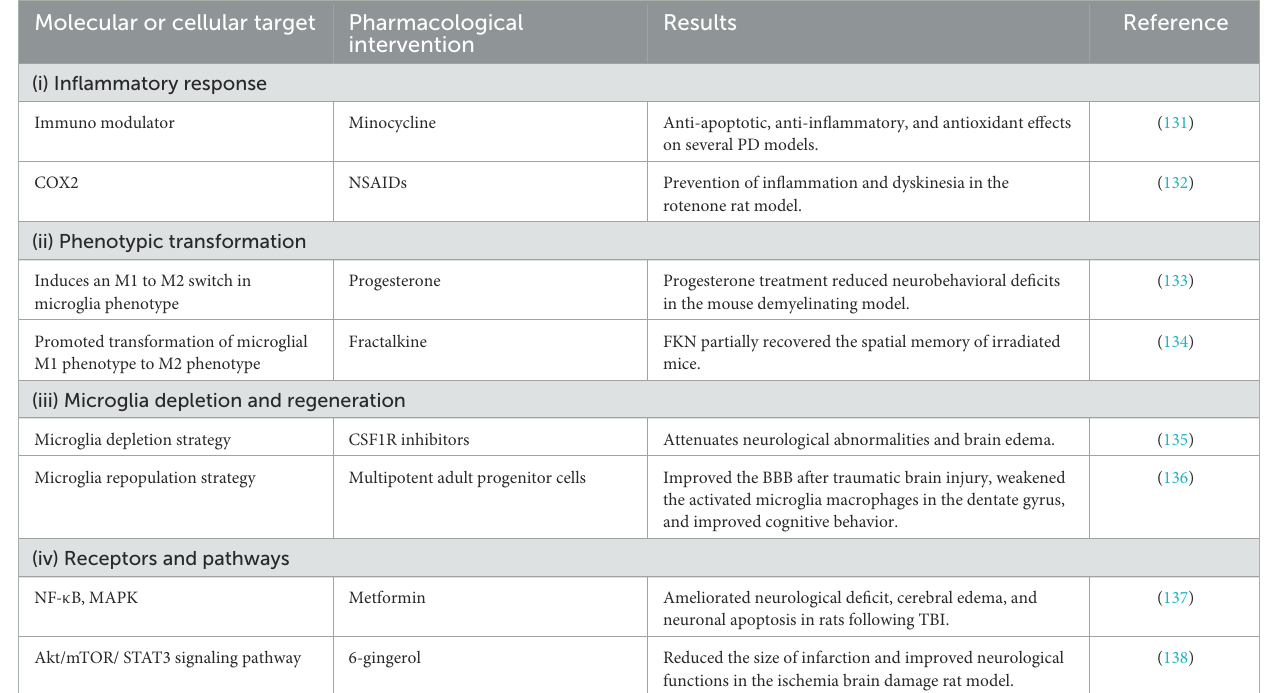
TABLE 2 Therapeutic strategy targeting microglia for CNS